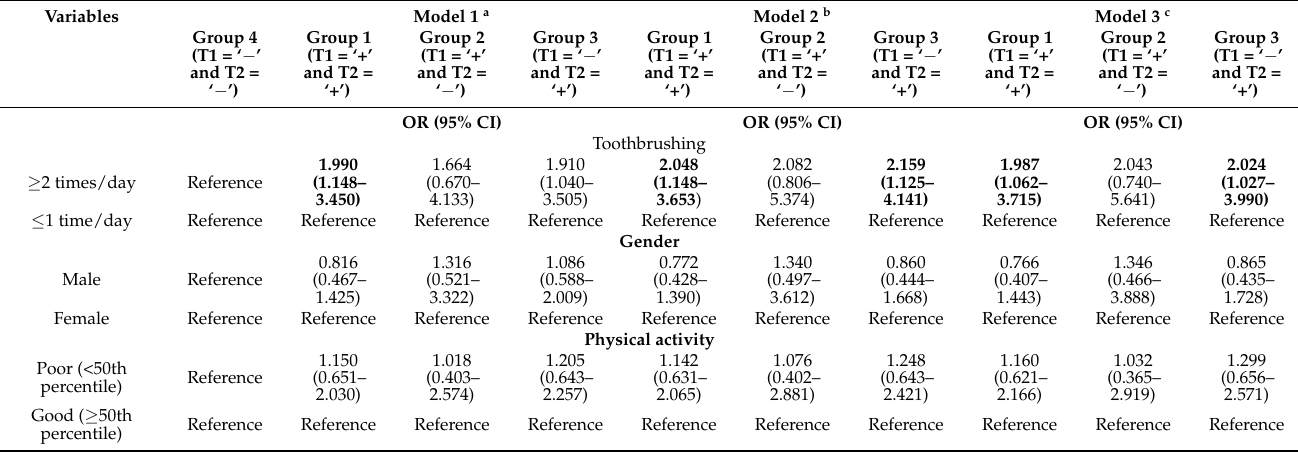
Table 5. Multinomial logistic regression models for the association between toothbrushing and change in metabolic syndrome after adjusting the